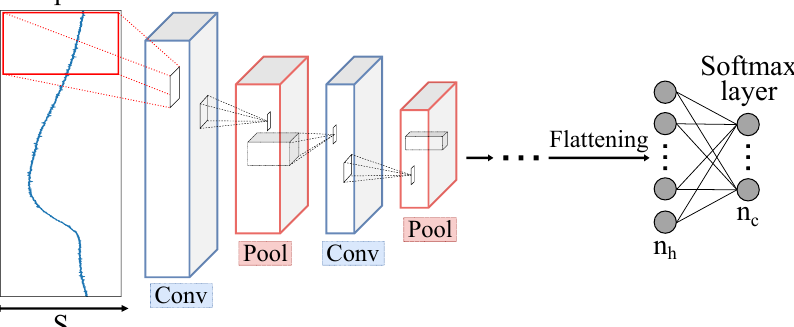
Figure 8. Schematic illustration of a Convolutional Neural Network (CNN) architecture with c output classes presented by a softmax layer. Input data is processed by Convolutional (blue) and Pooling (red) layers, extracting meaningful features which are fed to a combination of dense layers, similar to single MLP